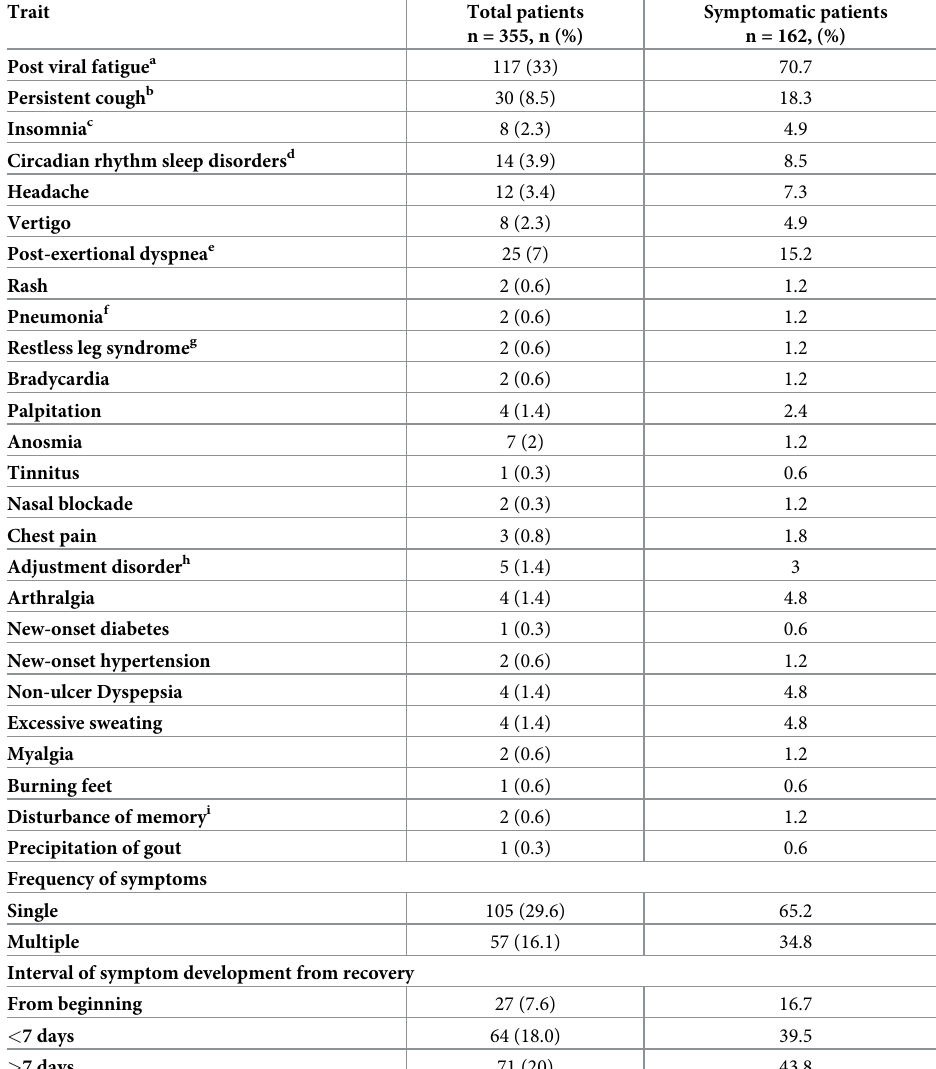
Table 2. Spectrum of post-COVID-19 symptoms.